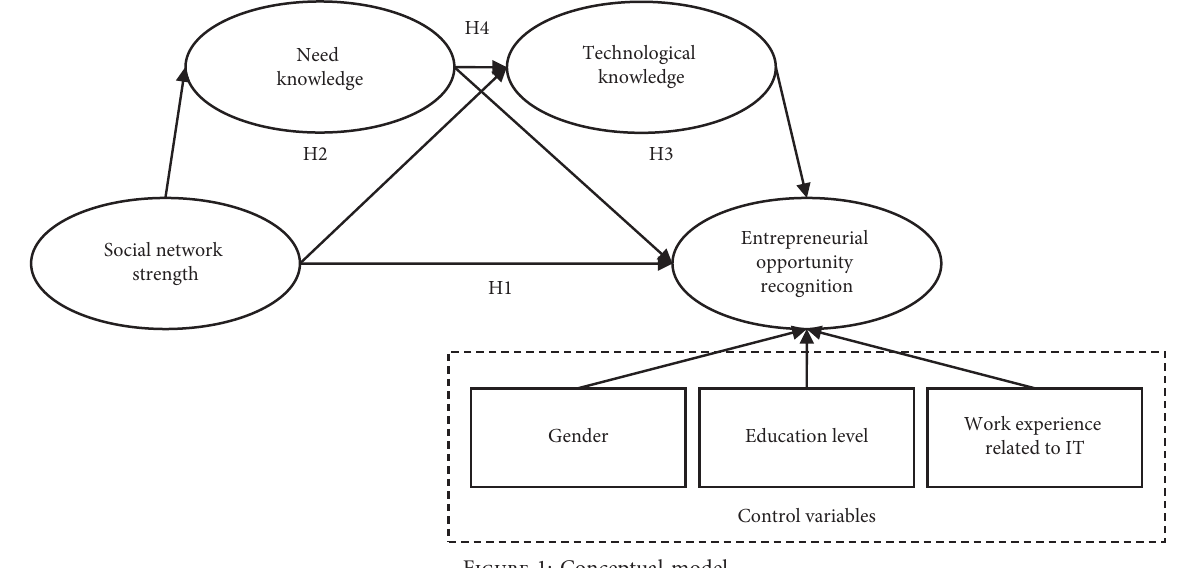
Figure 1: Conceptual